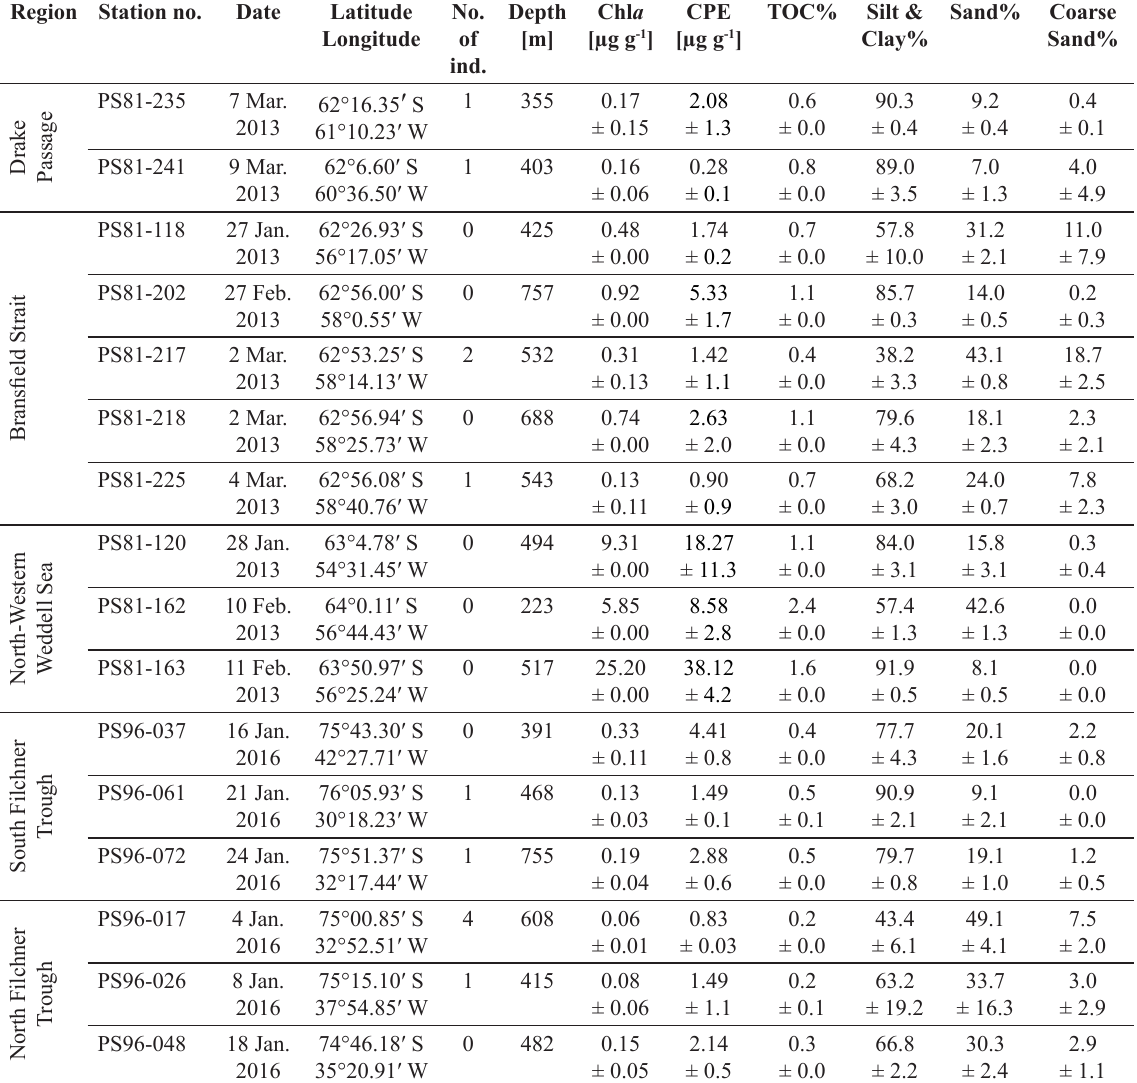
Table 1. Station list and sampling during RV Polarstern expeditions PS 81 (22 Jan.–18 Mar. 2013) around the Antarctic Peninsula (Drake Passage, Bransfield Strait, North-Western Weddell Sea) and PS 96 (6 Dec. 2015–4 Feb. 2016) to the South-Eastern Weddell Sea (South-Filchner Trough, North- Filchner Trough) with the abundance of Anobothrus konstantini Säring & Bick sp. nov. (No. of ind.) for each station. Sediment samples for environmental characterization were collected with the multicorer at the same stations (Säring et al. 2021a; Vanreusel et al. 2021a). Mean and standard deviation of environmental parameters are given for each station. Sediment parameters: Chl a = content of chlorophyll a ; CPE = sum of chlorophyll a and phaeopigments; TOC% = total organic carbon; Silt & Clay % = grain size fraction < 63 µm; Sand % = grain size fraction > 63 and < 500 µm; Coarse Sand% = grain size fraction > 500